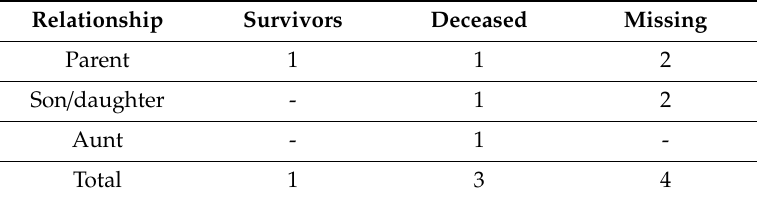
Table 1. Degree of relationship with the missing